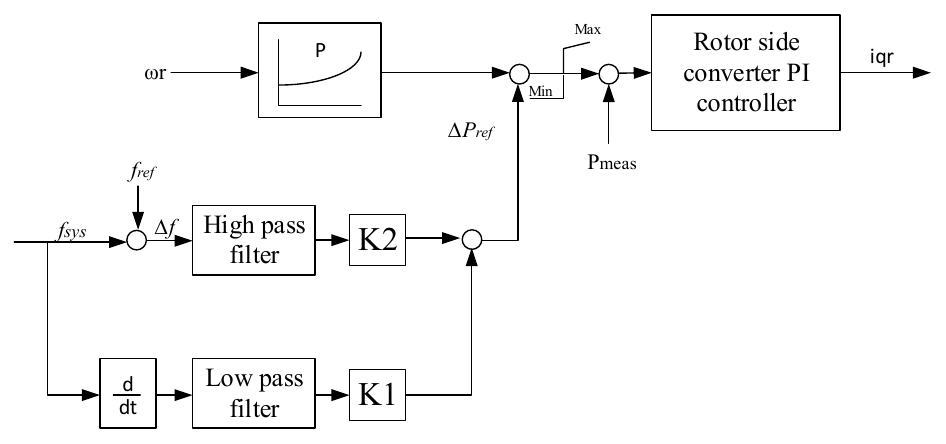
Figure 17. Schematic of inertial controller form torque control.